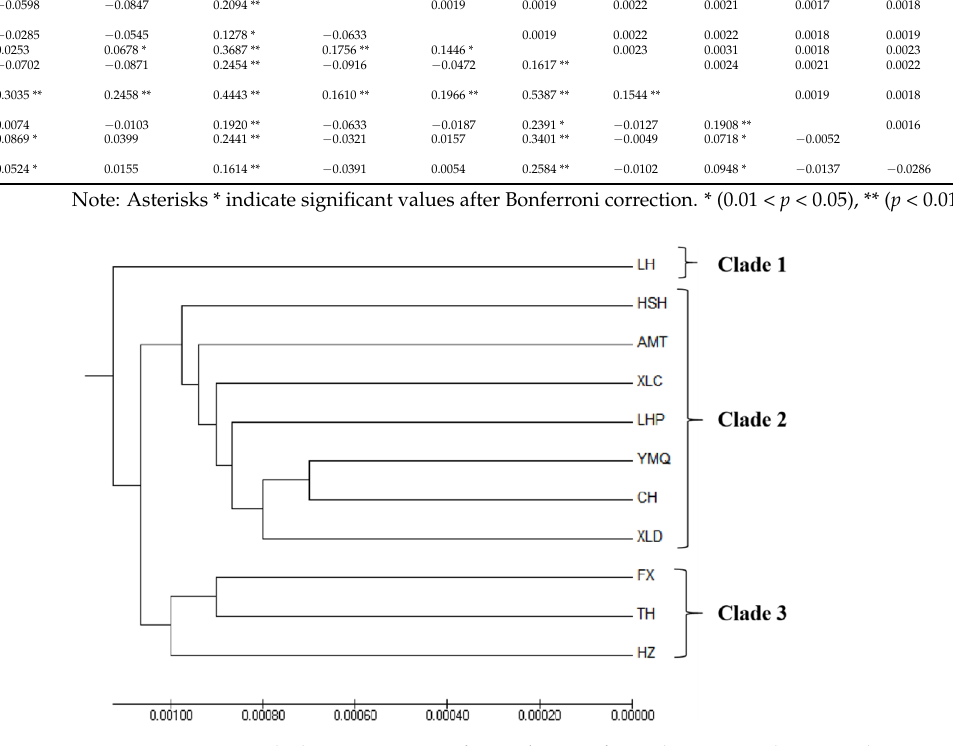
Figure 2. UPGMA phylogenetic trees of N. taihuensis from the 11 populations. The AMOVA results revealed that 90.37% of genetic variation occurred within populations, whereas 9.63% of genetic variation occurred among populations. An AMOVA of the 11 populations yielded an Fst value of 0.6452 ( p < 0.01), which suggested significant genetic variation among the 11 populations (Table 4). Table 4. AMOVA of N. taihuensis populations.